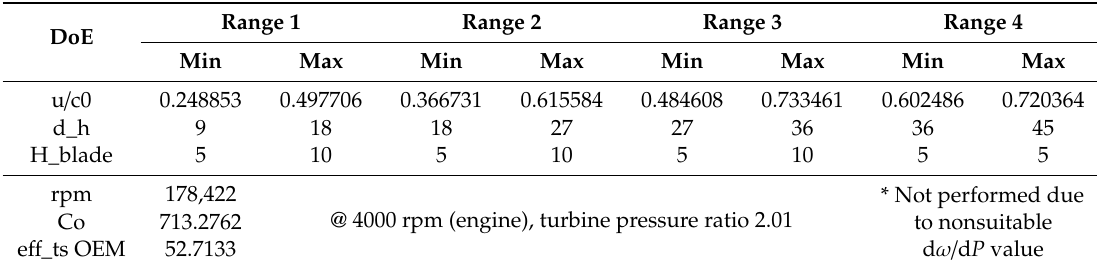
Table 4. Summary of Design of Experiment details at the final design point.